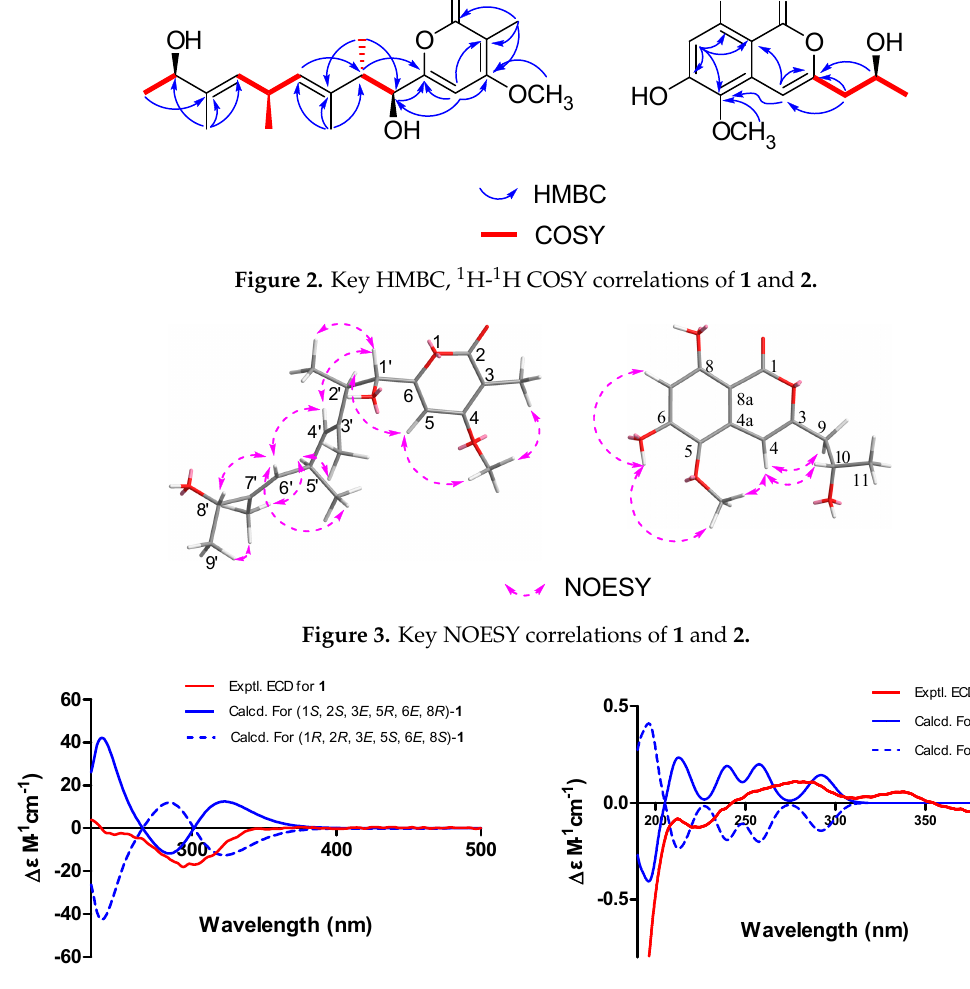
Figure 4. Experimental and calculated electronic circular dichroism (ECD) spectra of 1 and 2.